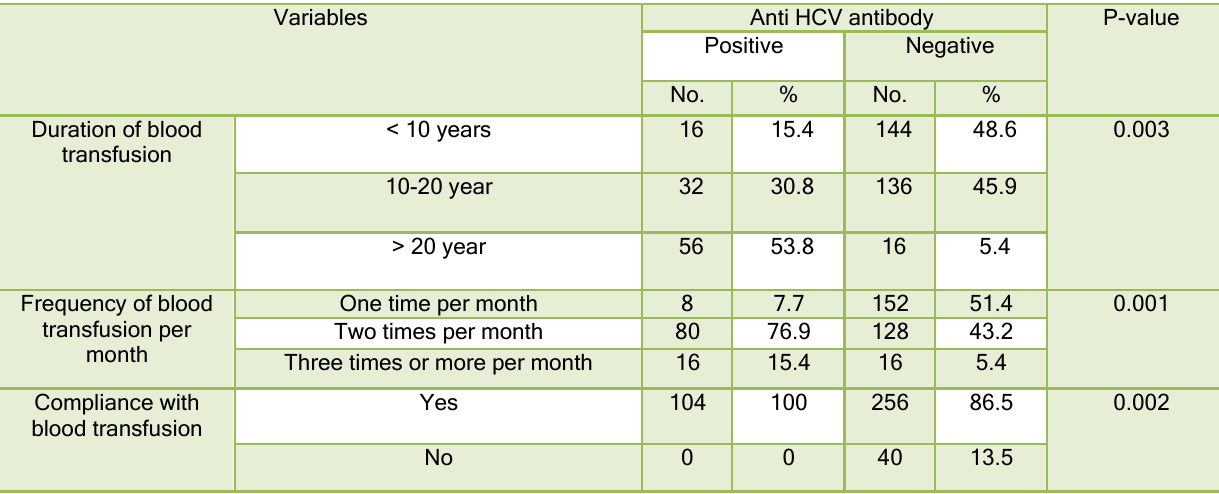
Table 3: The prevalence of Anti HCV antibody according to blood transfusion history.